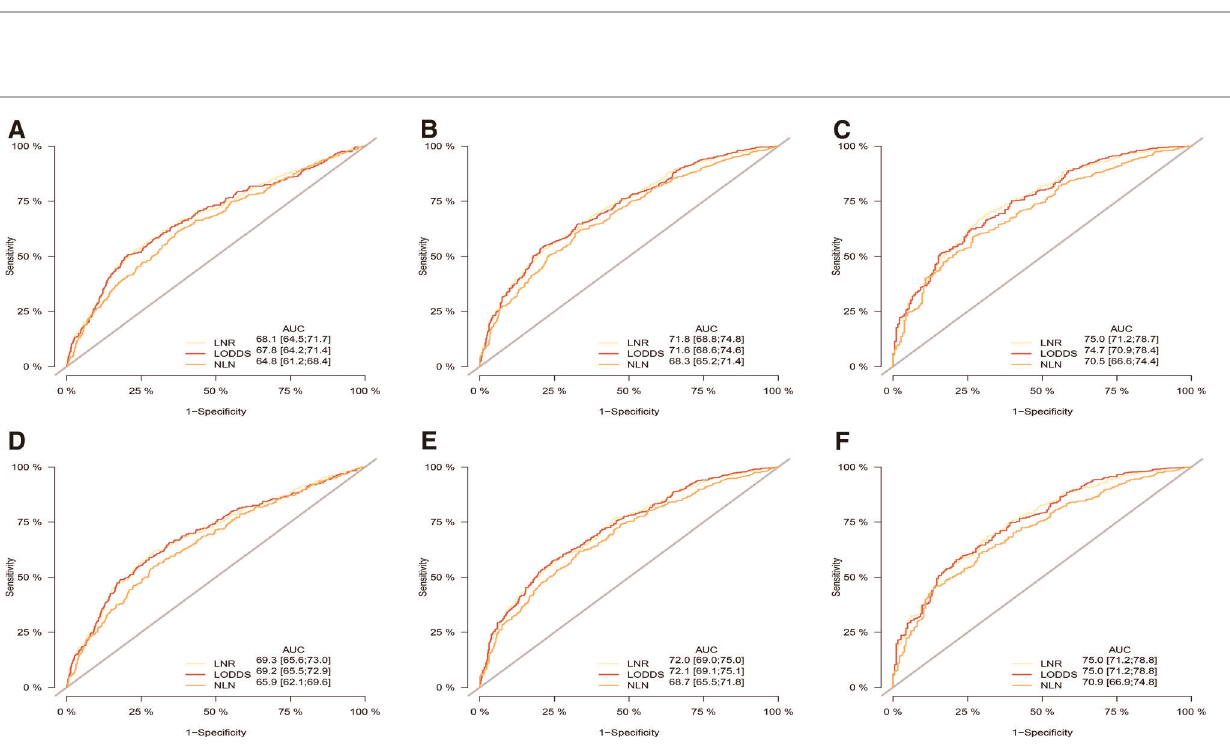
FIGURE 3 | ROC curve of the ypN stage, LNR, LODDS and NLN in the prediction of prognosis of gastric adenocarcinoma patients after NATat 1 ( A ), 3 ( B ), 5 ( C ) year point for OS and 1 ( D ), 3 ( E ), 5 ( F ) year point for CSS when LN status assessed as categorical varaible. OS, overall survival; CSS, cancer speci fi c survival; ROC, receiver operative curve; LNR, lymph node ratio; LODDS, log odds of positive lymph node; NLN, negative lymph node.